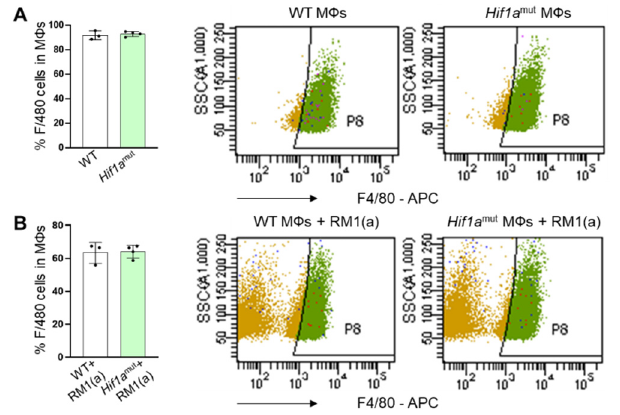
Figure A6. Flow cytometry analysis of F4/80 + expression in efferocytic and non-efferocytic BM macrophages from Hif1a flox/flox (WT) and Hif1a mut mice. BM macrophages (M Φ ) were isolated from 4 wk old Hif1a flox/flox (WT), Hif1a mut mice and co-cultured with apoptotic RM1(a) cells